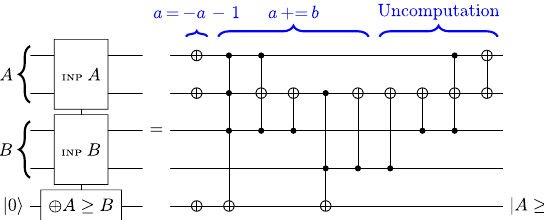
0 -triggered control ( | �